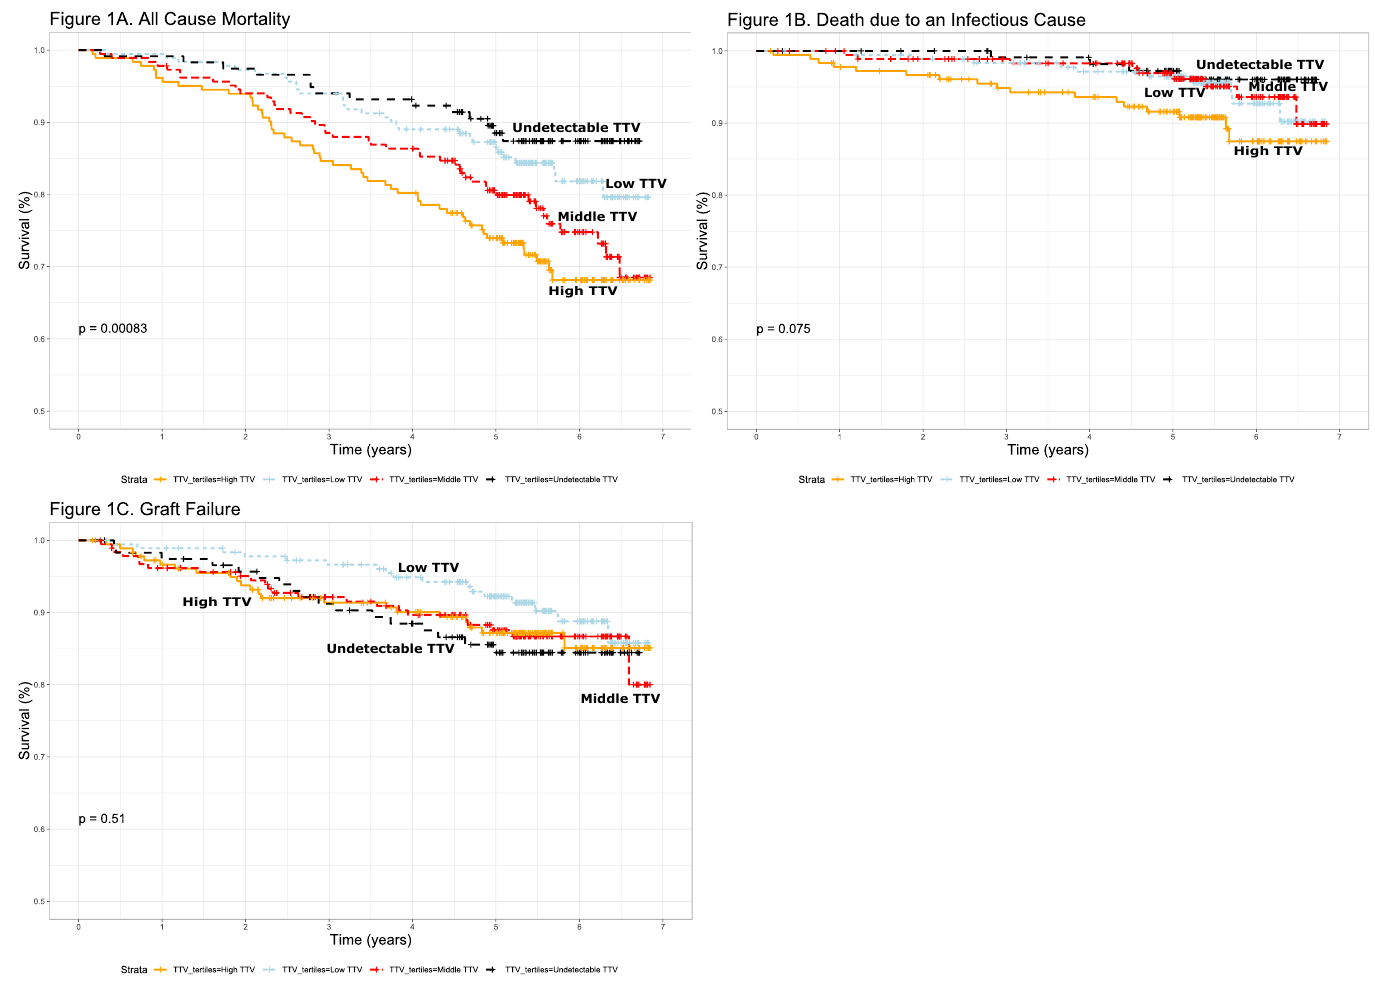
Figure 1. Kaplan–Meier plots showing di ff erences in survival ( A , B ), and graft failure ( C ) over time between undetectable low torquetenovirus TTV (black), low TTV (light blue), medium TTV (red) and high TTV (orange), as measured in a serum sample tested at least 12 months after transplantation. Time from testing is displayed ( A ) All-cause mortality ( p < 0.001, ( B ) Death due to infectious causes ( p = 0.08), ( C )) graft survival ( p =